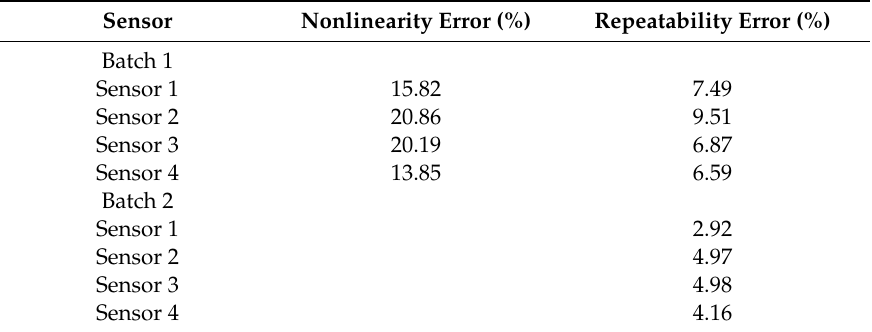
Table 2. Repeatability and non-linearity error (%) for FlexiForce ® sensors of batch 1 and